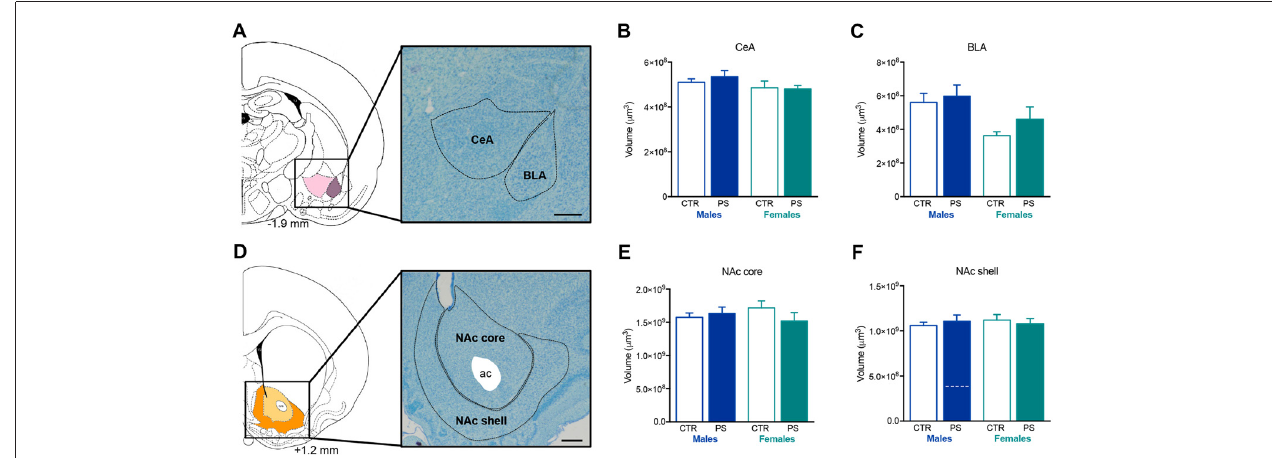
FIGURE 6 | PS exposure does not alter the volume of the amygdala or the nucleus accumbens (NAc). (A) Representative image of the amygdala sub-regions, central amygdala (CeA) and basolateral amygdala (BLA), using a methacrylate coronal section of a rat’s brain; numbers represent distance to Bregma; scale bar = 1 mm. PS exposure does not alter the volume of (B) CeA or (C) BLA of both male and female PS rats in comparison with same-sex controls (rats n PS males = 6, n CTR males = 4, n PS females = 5, n CTR females = 3). (D) Representative image of the NAc sub-regions, NAc core and NAc shell, using a methacrylate coronal section of a rat’s brain; numbers represent distance to Bregma; scale bar = 1 mm. PS exposure does not alter the volume of (E) NAc core or (F) NAc shell of both male and female PS rats in comparison with same-sex CTR (rats n PS males = 9, n CTR males = 4, n PS females = 5, n CTR females = 3). Error bars denote